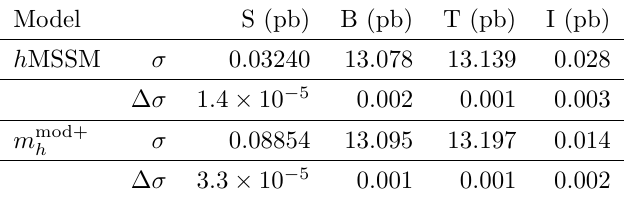
Table 5 . Parton level results for the h MSSM and m mod+